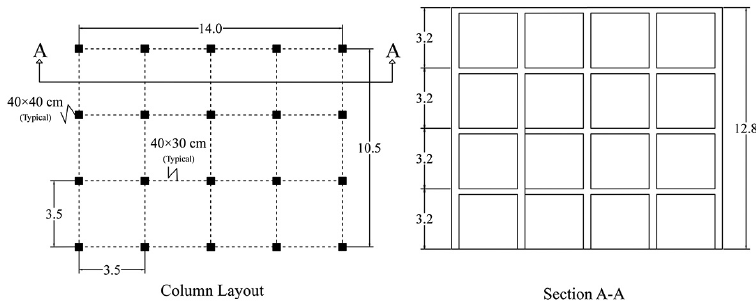
Fig. 1. Column layout and elevation (unspecified dimensions are in meters)